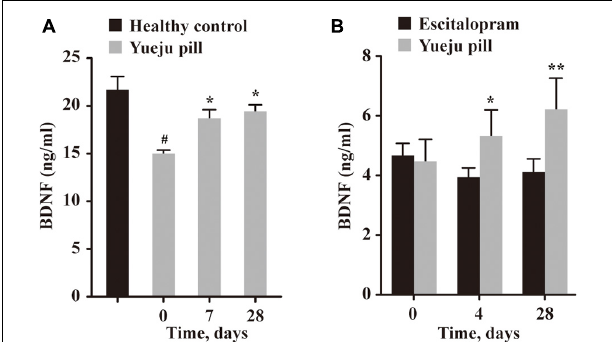
were analyzed separately. When the data in were collapsed, the baseline serum BDNF levels and HAMD-24 scores were found to be negatively correlated ( R 2 = 0.21, p = 0.002). Additionally, analysis of collapsed data from two trials indicated serum BDNF levels and HAMD-24 scores at D28 post treatment were also negatively correlated ( R 2 = 0.11, p =